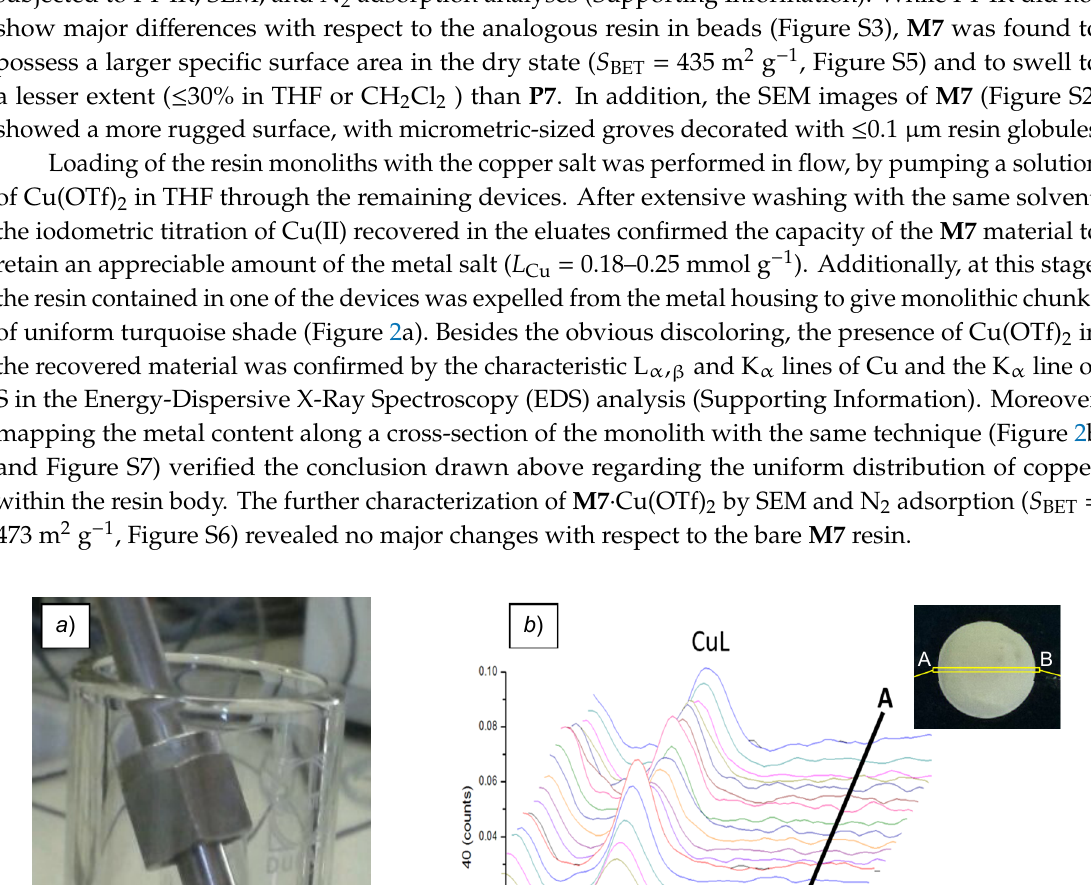
Table 1. Copper-catalyzed azide-alkyne cycloaddition reaction (CuAAC) runs in batch with P7 loaded with Cu(I) or Cu(II) salts.